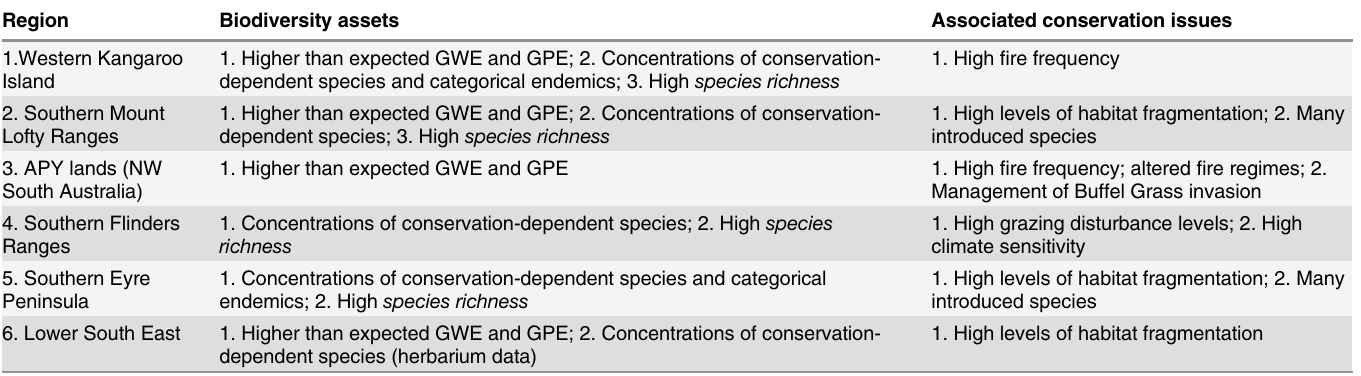
Table 2. Identified centres of plant biodiversity in South